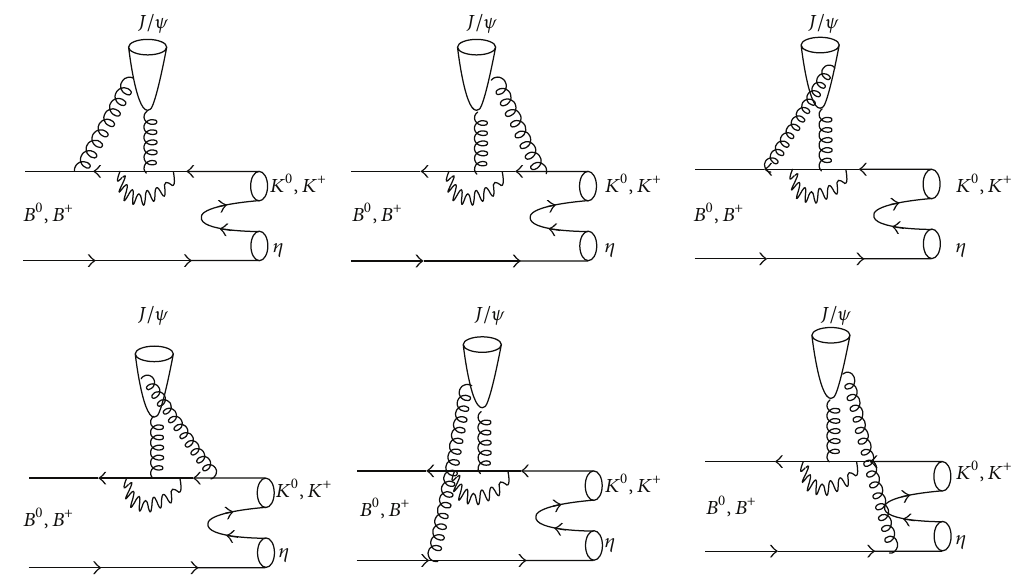
Figure 2: Nonfactorizable diagrams for 𝐵 0 → 𝐽/𝜓𝜂𝐾 0 and 𝐵 + → 𝐽/𝜓𝜂𝐾 +